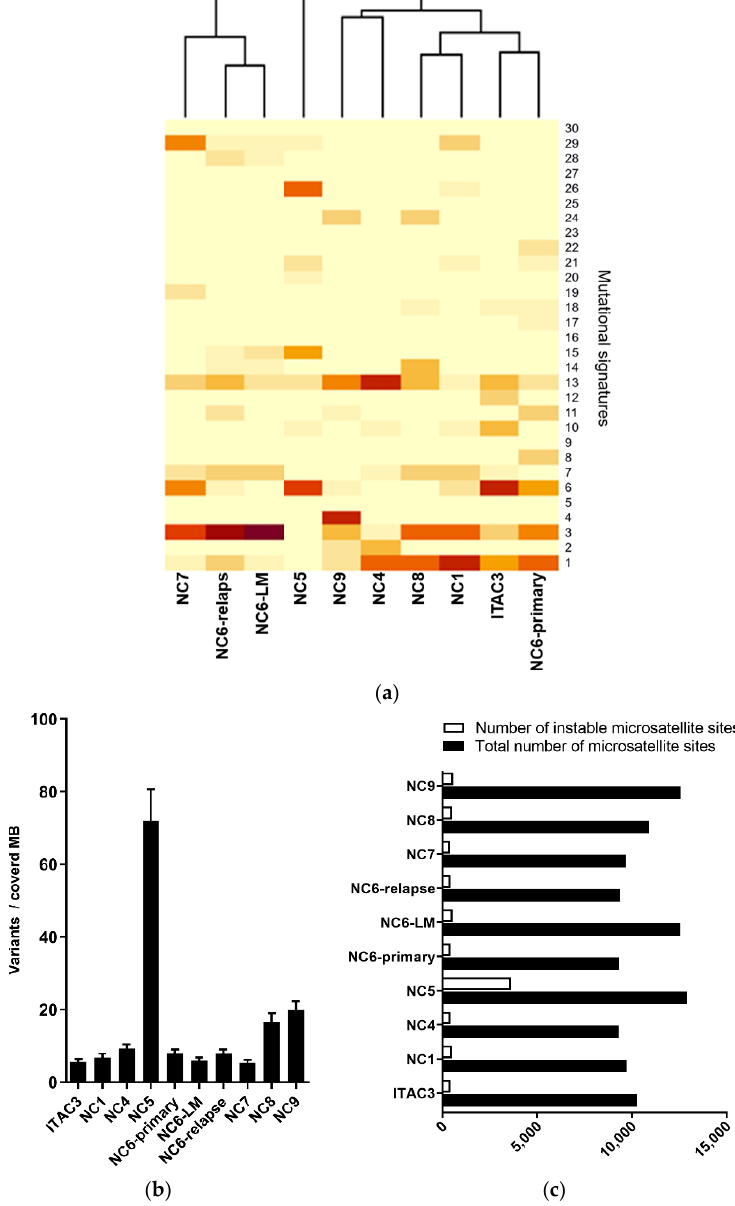
Figure 1. Mismatch repair deficiency signature in SNSCC cell line. ( a ) Mutational signature analysis based on WES of 6 patient-derived sinonasal squamous cell carcinoma (SNSCC) cell lines (NC) and one patient’s lymph node metastasis (NC6-LM)/tumor recurrence (NC6-relapse). A sinonasal intestinal type adenocarcinoma (ITAC3) revealed a mismatch repair-deficient signature of NC5 (signature 6, 15, 20, 26). NC6-primary, ITAC3, NC1, NC4 and NC8 clustered with the highest impact of age-associated signature (1). NC6-primary, ITAC3, NC1 and NC8 showed alteration resembling homologous recombination (HR) repair system deficient tumors (signature 3), which was the predominant signature of NC6-relapse, NC6-LM and NC7 (signature 3). NC9 mostly collected smoking-associated mutations (signature 4). ( b ) Tumor mutational burden (TMB) analysis of cell line samples revealed an average of variants per covered mega base (MB) of 13.67 for non- synonymous and for all coding sequencings of 17.784, confirming a TMB-high status for NC5. ( c ) Analysis of microsatellite sites in WES data of cell lines elucidated an abnormal percentage of instable microsatellite regions compared to all analyzed sites in individual normal tissue control, classifying the NC5 as a highly microsatellite instable (MSI-H)